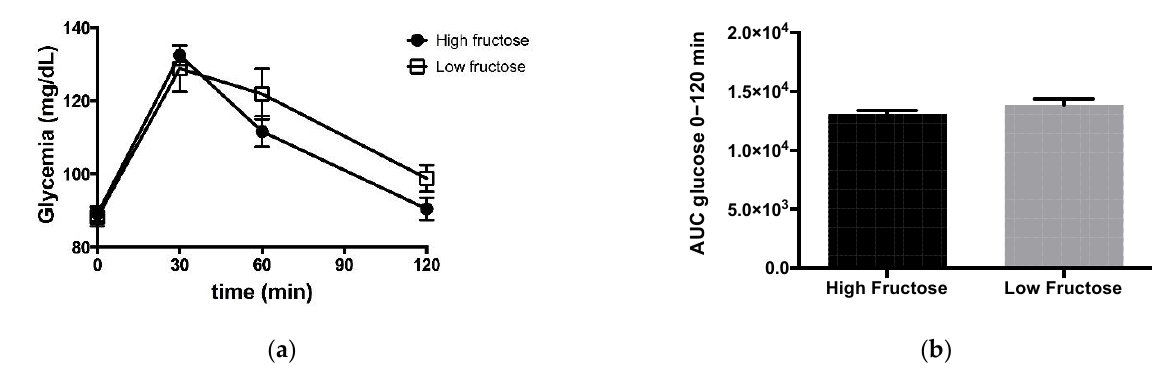
Figure 3. ( a ) Glycemic profile for the high and low fructose studies. Data points are represented as means ± SEM. ( b ) Area under the curve (AUC) for each meal are shown on the right-hand side. AUC values are represented by arbitrary units.